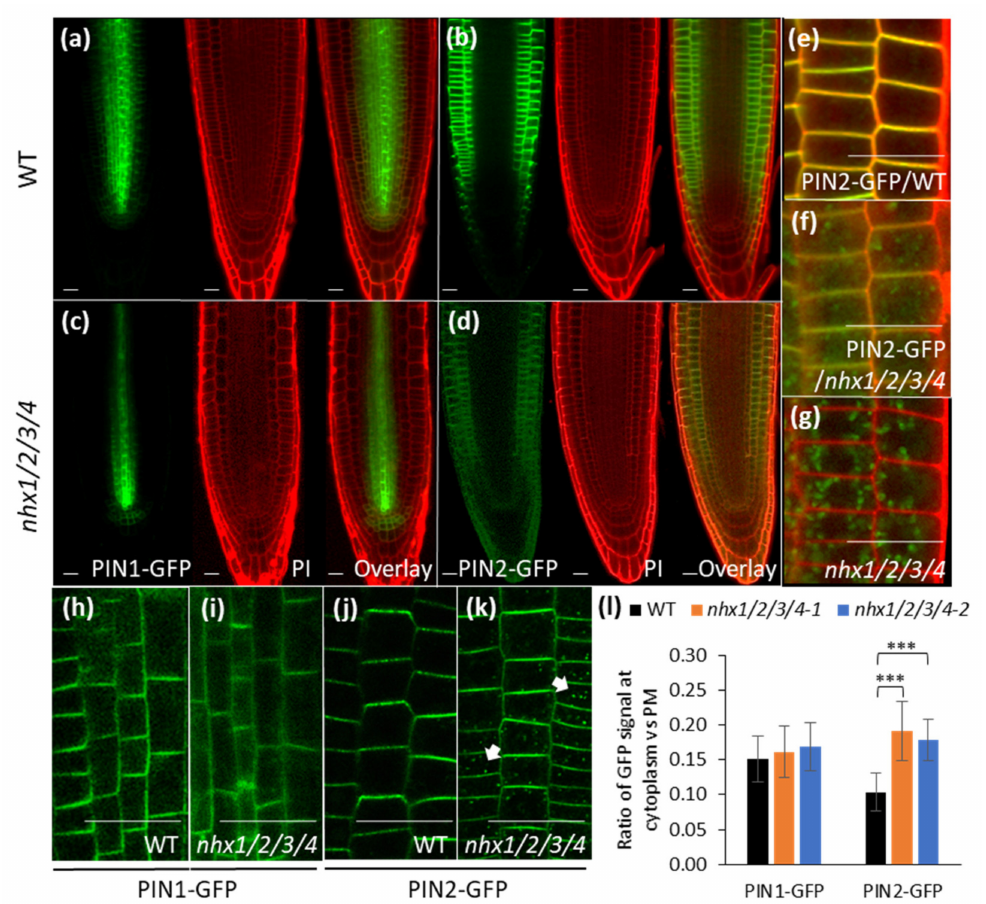
Figure 3. Expression and subcellular localization of PIN1 and PIN2. wild type (WT) and nhx1nhx2nhx3nhx4 ( nhx1 / 2 / 3 / 4) root tips are shown in ( a , b ) respectively. Localization of PIN1-GFP ( a ) and PIN2-GFP ( b ) in WT; and PIN1-GFP ( c ) and PIN2-GFP ( d ) in nhx1nhx2nhx3nhx4 . Closeup of PIN2-GFP in WT ( e ) and nhx1nhx2nhx3nhx4 ( f ). ( g ), autofluorescence signal (green) in nhx1nhx2nhx3nhx4 roots. Roots were counter stained with propidium iodide (PI) in ( a – g ). ( h , i ), the subcellular localization of PIN1-GFP in WT ( h ) and nhx1nhx2nhx3nhx4 ( i ). ( j , k ), the subcellular localization of PIN2-GFP in WT ( j ) and nhx1nhx2nhx3nhx4 ( k ). Arrows in ( k ) indicate the intracellular PIN2-GFP vesicles. ( l ), the ratio of PIN1-GFP and PIN2-GFP signal intensity in the cytosol to that at the PM (values are mean ± SD; n ≥ 10; ***, p < 0.001 by t test). Scale bar, 20 µ